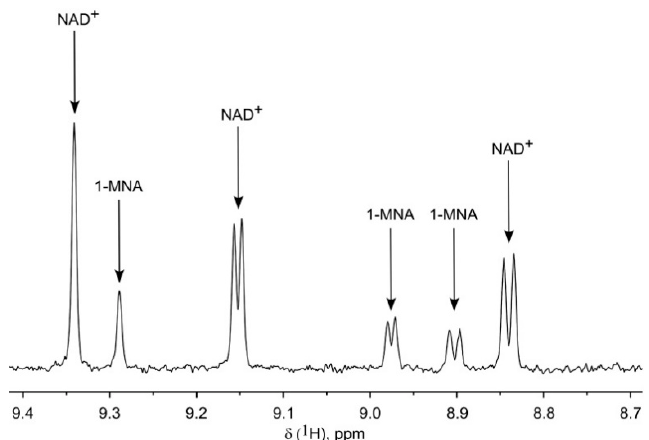
Figure 4. Detection of 1-MNA in human cell extracts. Characteristic region of 1 H NMR spectrum of cell extract obtained from HeLa cells cultivated in the presence of Nam. nt = 416.